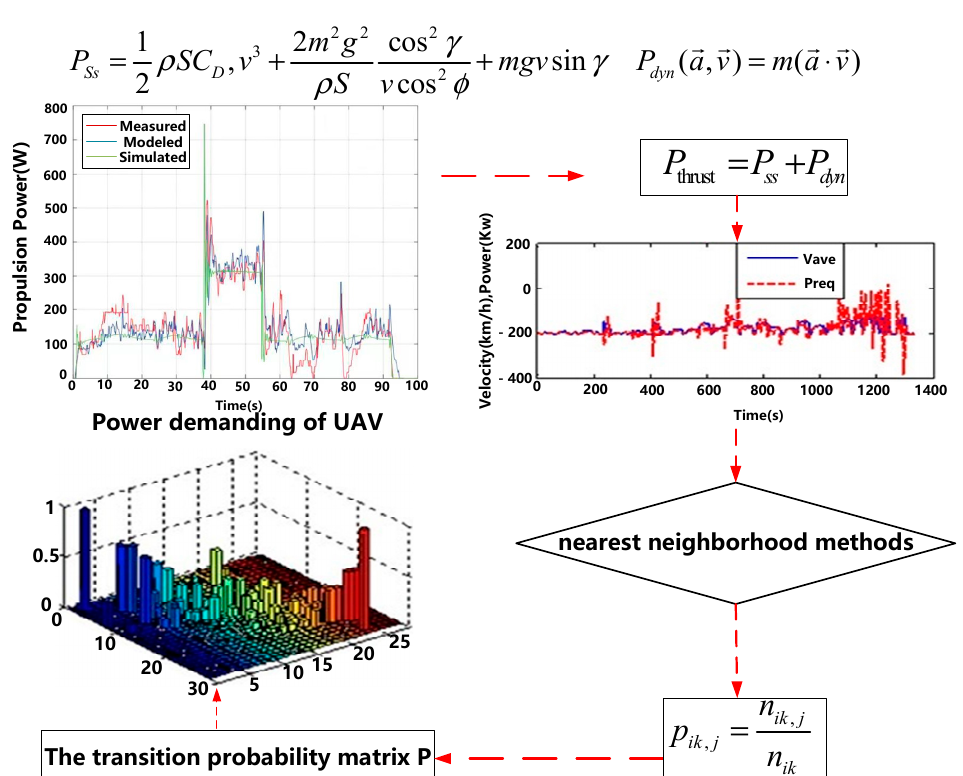
Figure 15. The probability matrix of load power demand for EMS strategy of the electrical propulsion UAV.